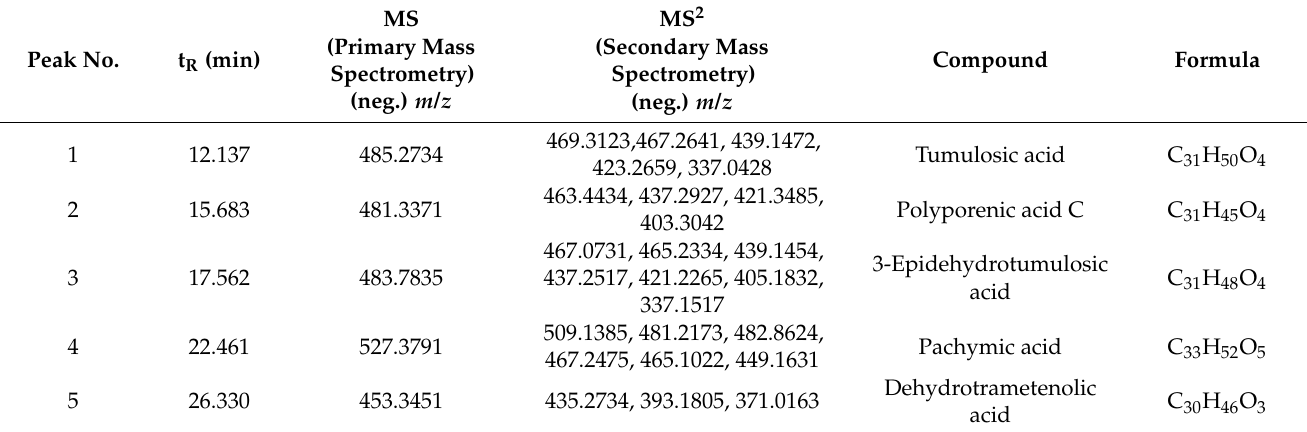
Table 1. Retention time (t R ) and negative electrospray ionization-mass spectra (ESI-MS) of the peak in UPLC.